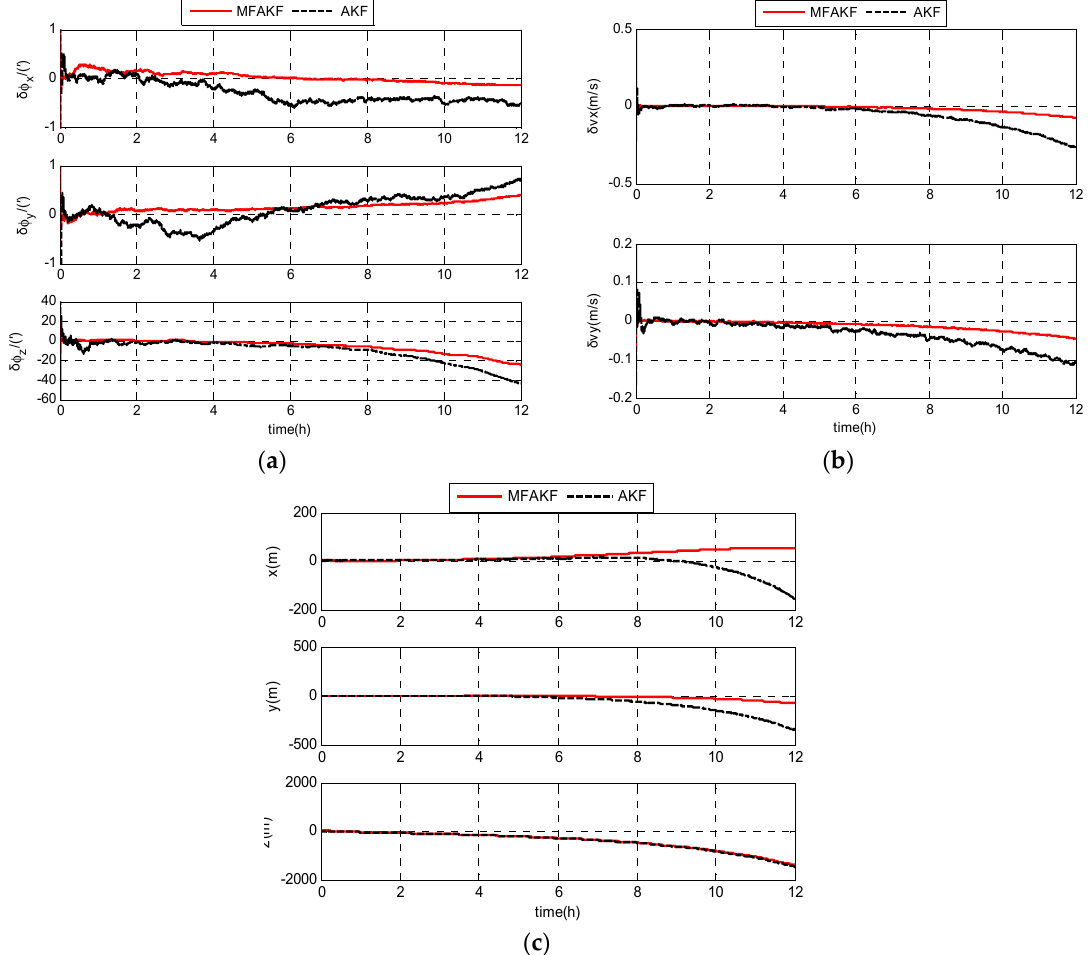
Figure 6. Simulation results of SODINS based on MFAKF and AKF: ( a ) estimation errors of attitude; ( b ) estimation errors of velocity; and ( c ) estimation errors of position.